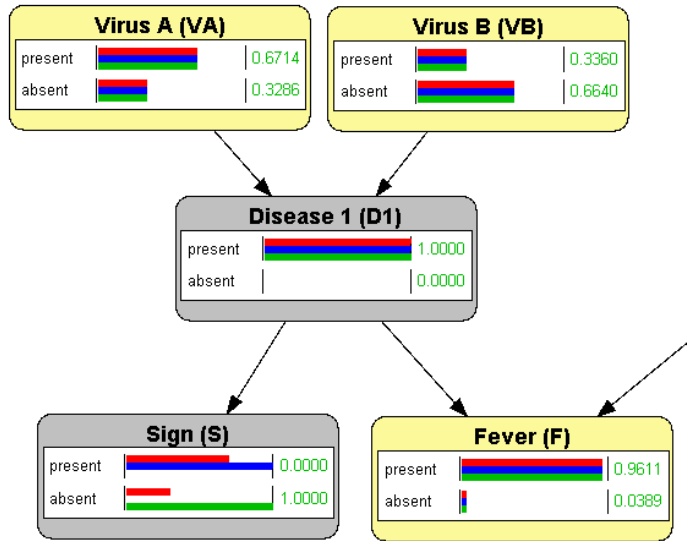
Figure 2. An example of conditional independence: once we know with certainty that disease 1 is present, no finding about sign S affects the probability of fever or the suspicion about the